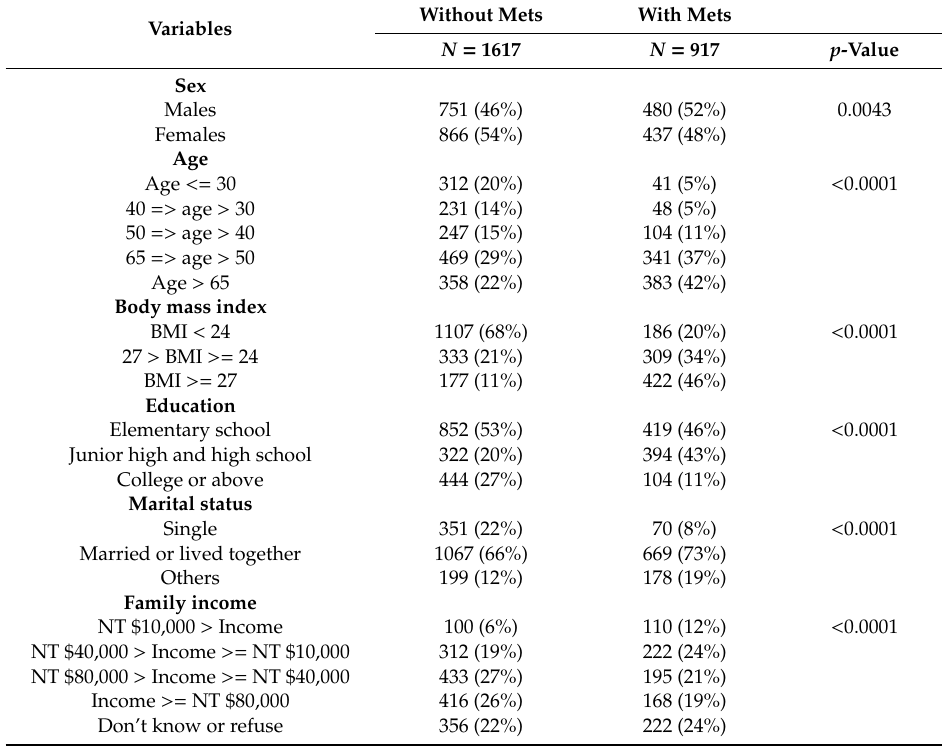
Table 2. Demographic description of included participants (N =